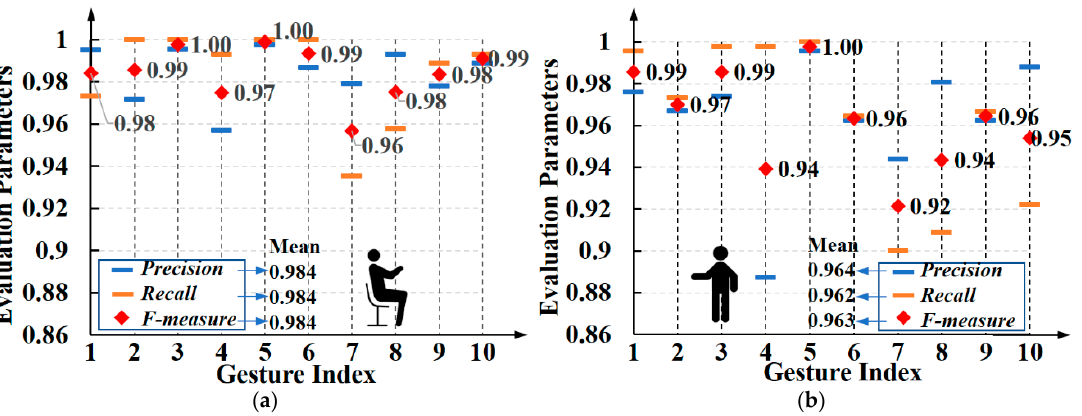
Figure 11. ( a ) The precision, recall, and F-measure of gesture classification in sitting conditions; ( b ) The precision, recall, and F-measure of gesture classification in standing conditions.